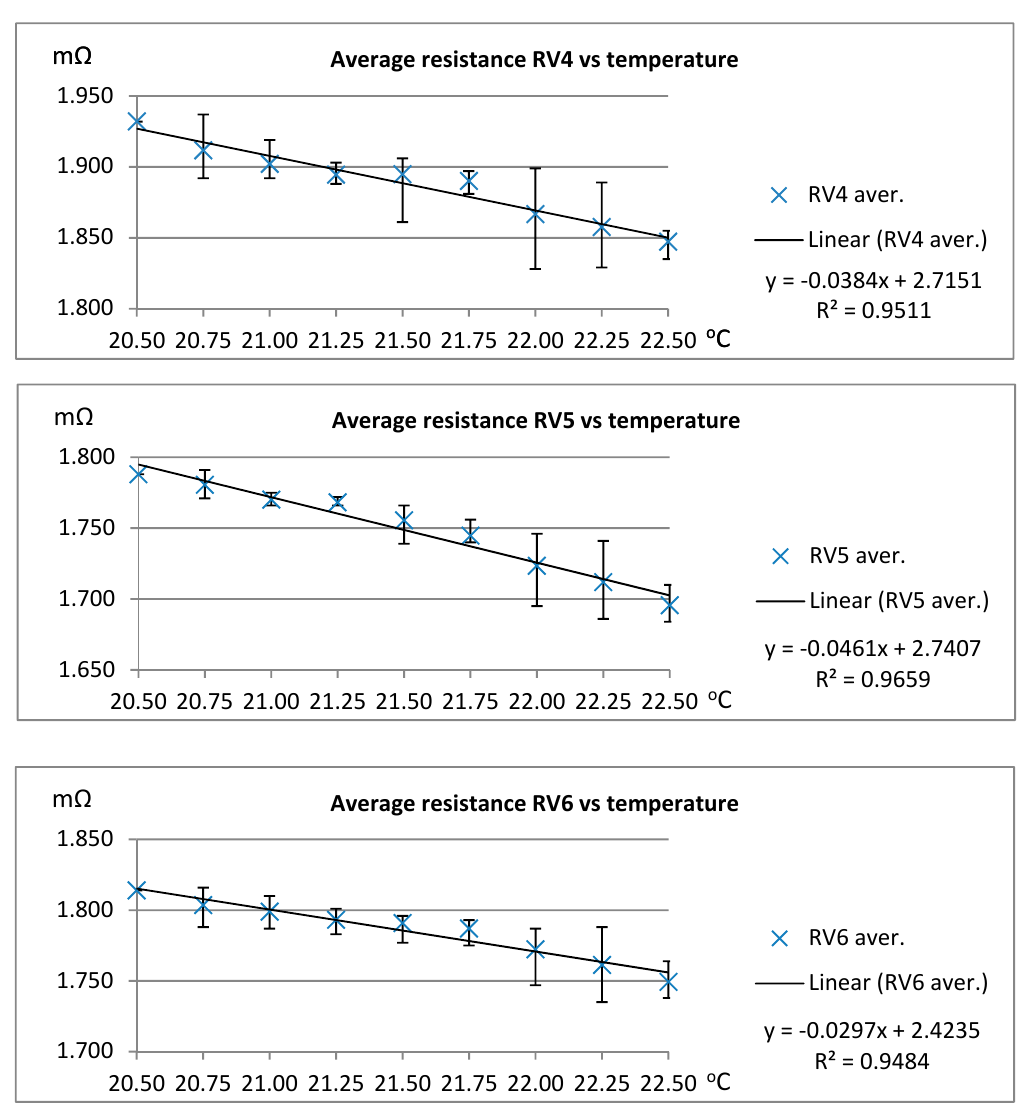
Figure 9. Average resistance of RV1 to RV3 vs. temperature .